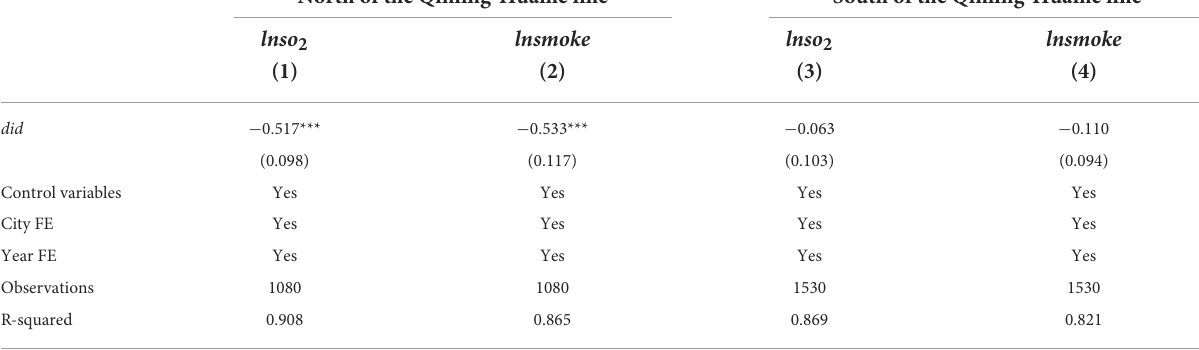
TABLE 6 Comparison of environmental tax reform effects in different